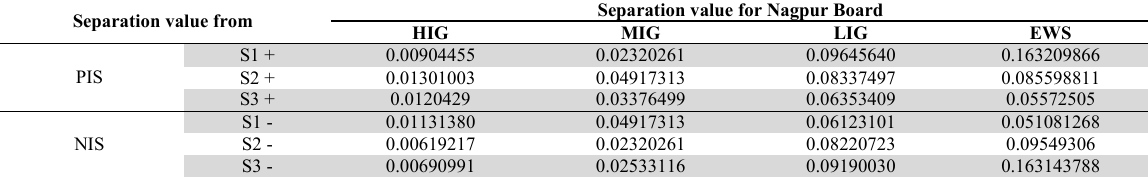
Table 5 Separation values for every alternative - Nagpur Board Separation value from